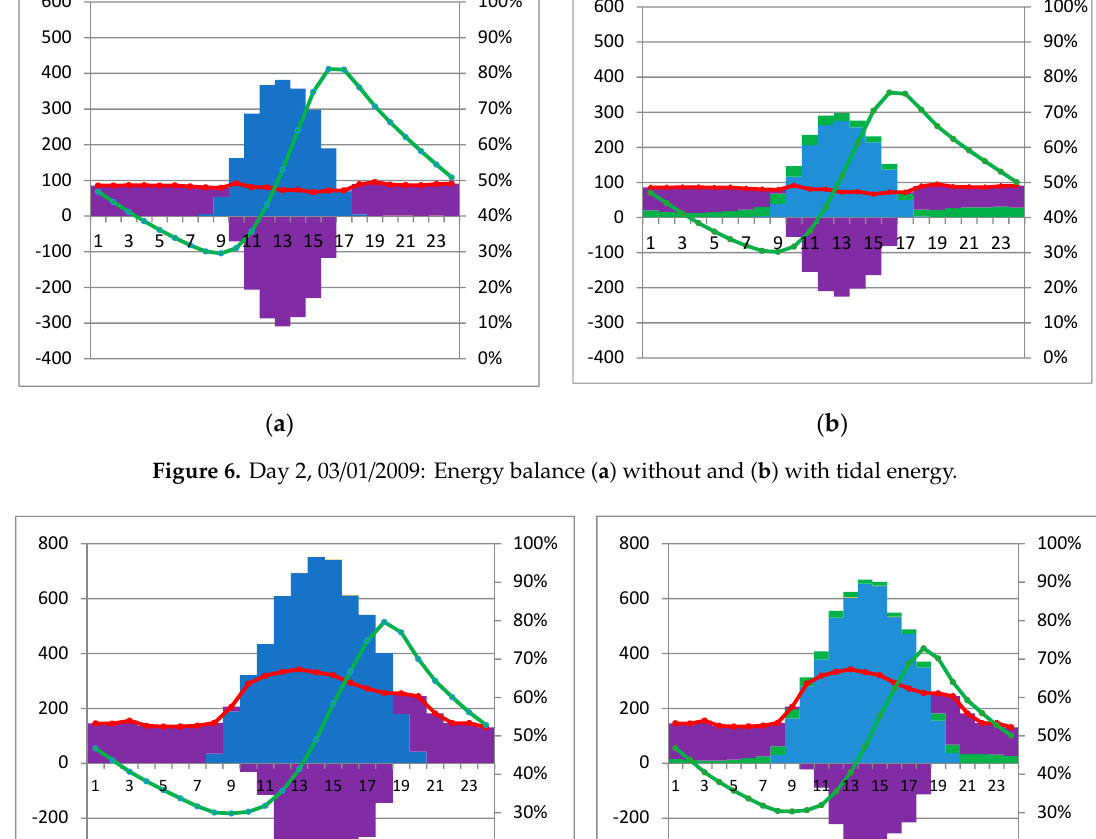
Figure 5. Day 1, 25/02/2009: Energy balance ( a ) without and ( b ) with tidal energy.